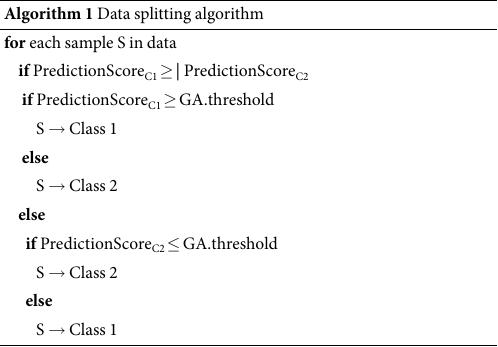
Algorithm 1 Data splitting